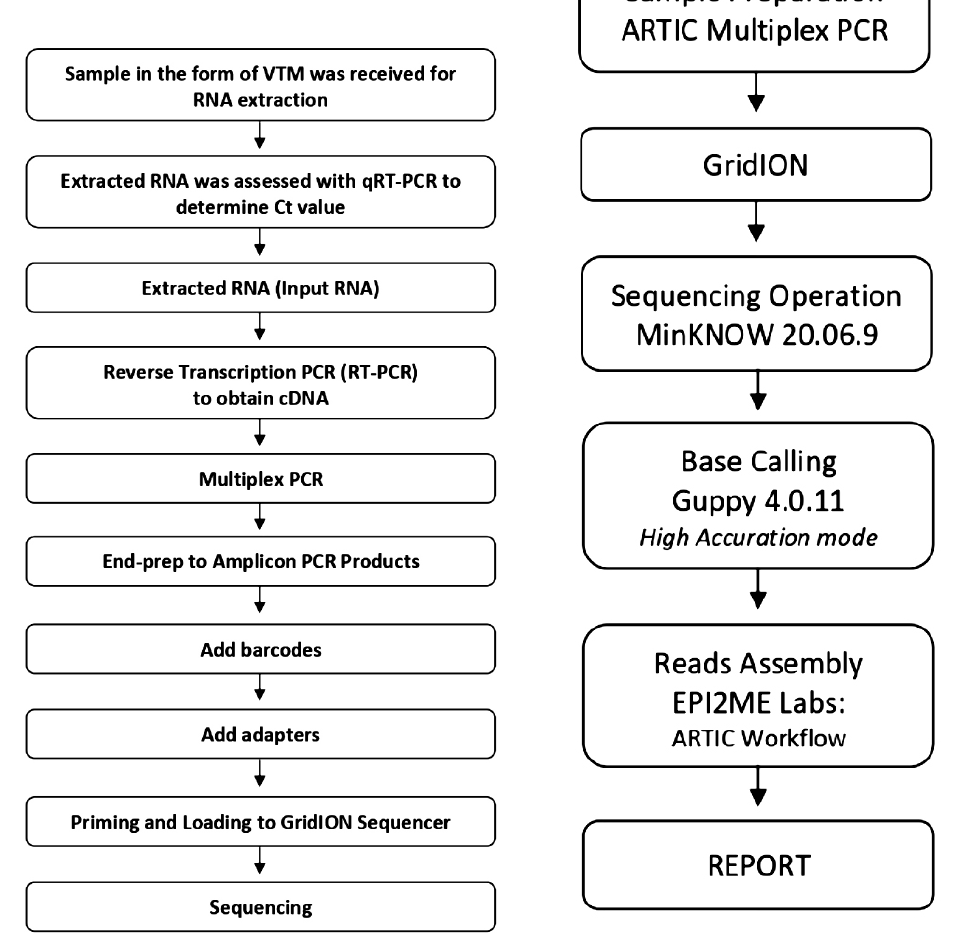
Fig. 1. Experimental workflow of sequencing Fig. 2. Bioinformatic workflow